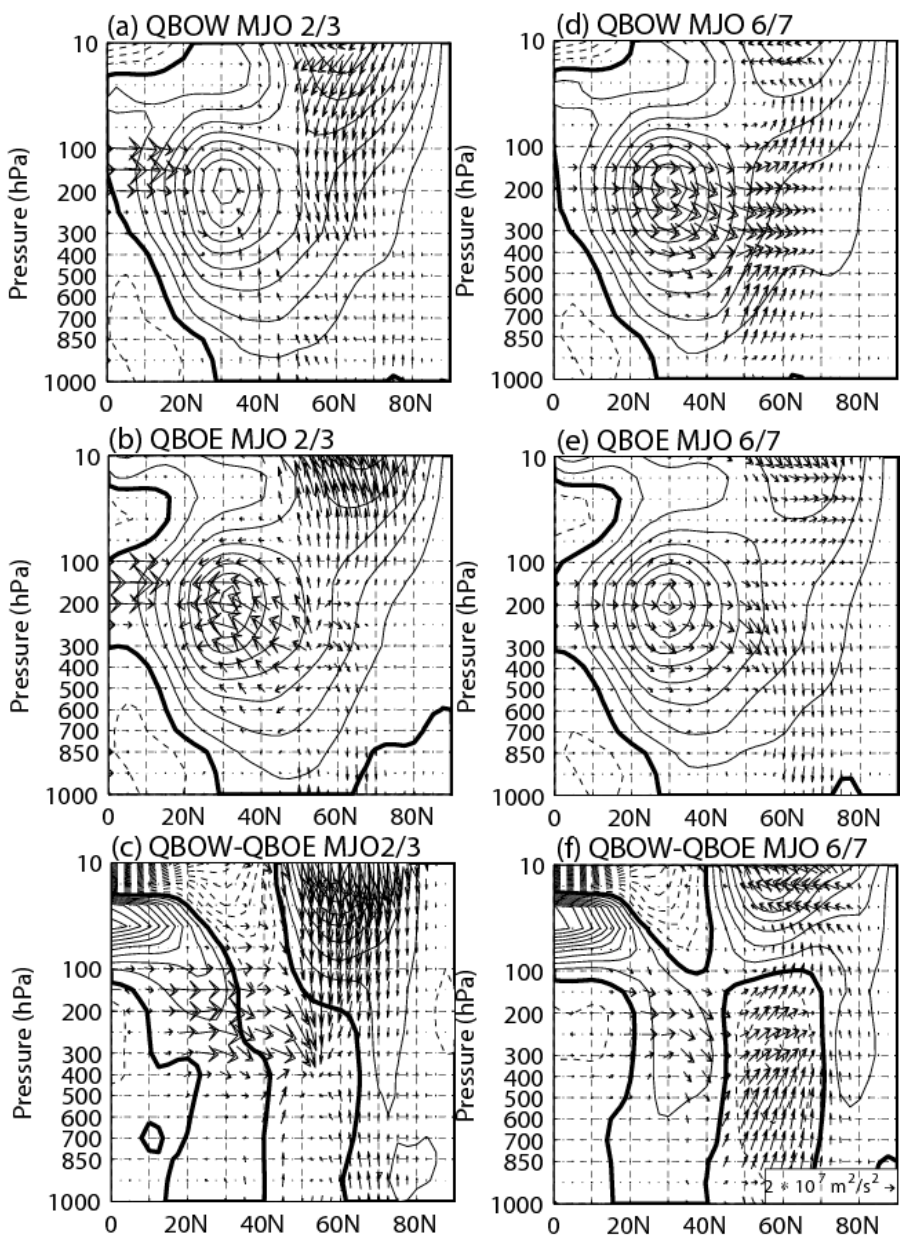
Figure 6. Latitude–height vertical cross-section of zonal-mean zonal wind (contour, interval: 5 m/s) and Eliassen–Plam flux anomalies (vector, scale on the right bottom) averaged from 10 to 14 days after the MJO phase 2/3 in QBOW ( a ), QBOE ( b ) years, and the difference between the QBOW and QBOE years ( c ). Subplots ( d )–( f ) are the same as ( a )–( c ) but for the MJO phase 6/7. The vertical component of the E-P flux has been multiplied by 100.